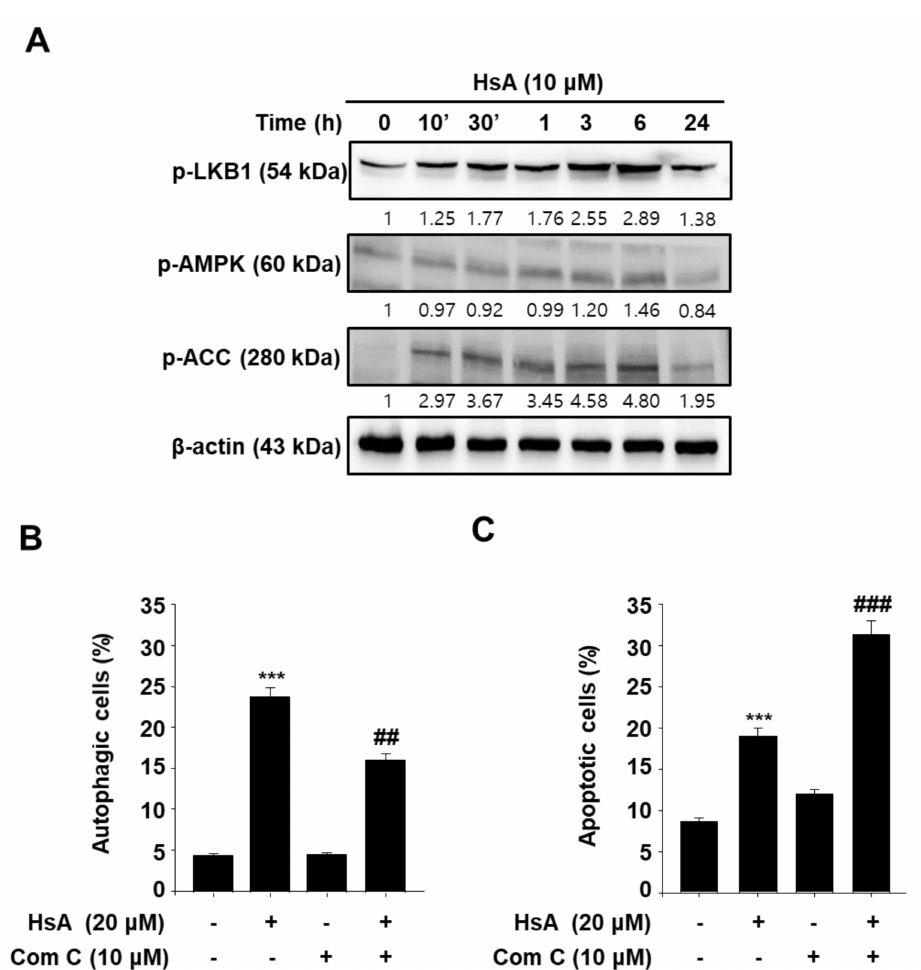
Figure 4. AMPK activation regulates Hemistepsin A (HsA)-induced autophagy and apoptosis in prostate cancer PC-3 cells. ( A ) Western blot analysis for p-AMPK, p-ACC and p-LKB1. PC-3 cells were treated with 20 µ M HsA for the indicated times. ( B ) Effect of Compound C on HsA- induced autophagy. ( C ) Effect of Compound C on HsA-induced apoptosis. After the treatment with Compound C for 1 h, PC-3 cells were treated with 20 µ M HsA. Autophagic and apoptotic cells were detected by flow cytometry. All data are representative of at least three independent experiments. Data show mean ± SD. *** p < 0.001 compared with the control group; ## p < 0.05, ### p < 0.001 compared with the HsA treated